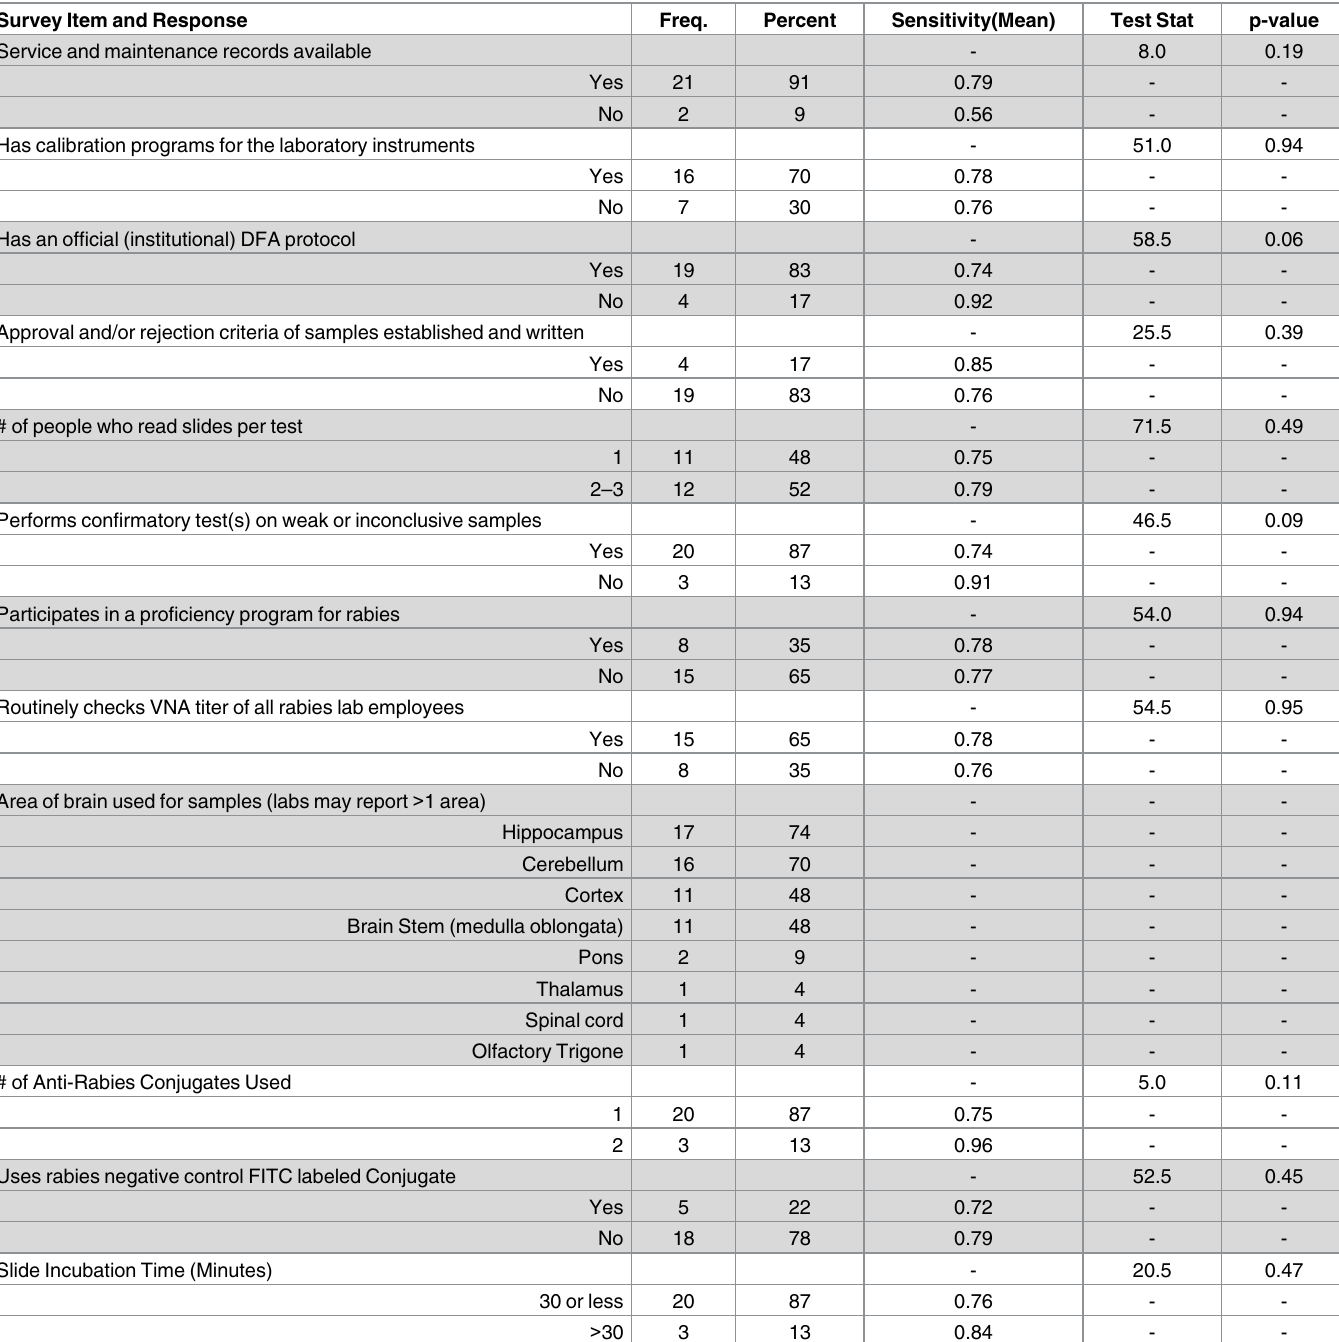
Table 5. Selected questions of the rabies laboratory practicesquestionnaire and results. Survey Item and